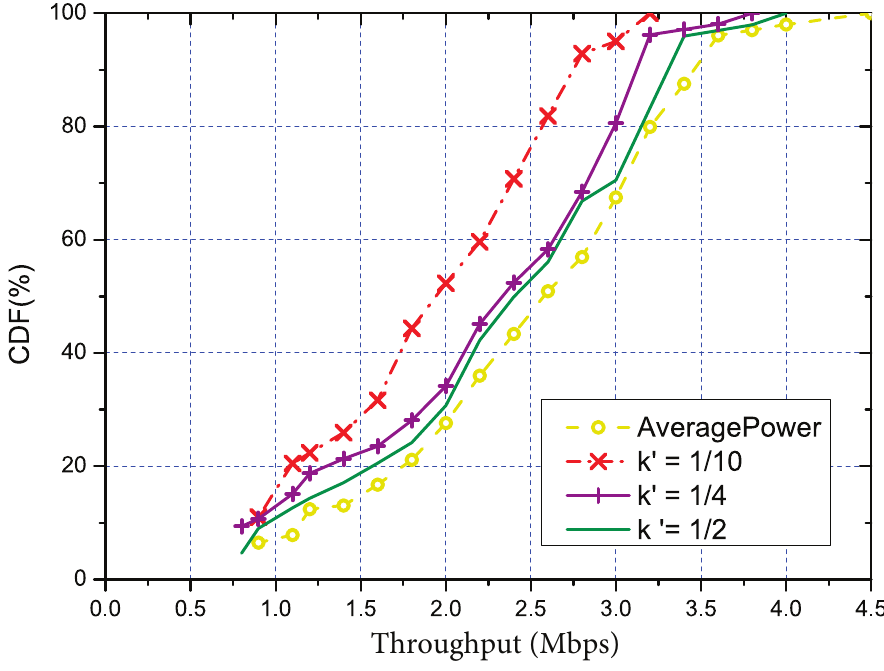
Figure 5. The CDF of throughput under different k (cid:48) , where k (cid:48) stands for the ratio of representative links to the total number of links.